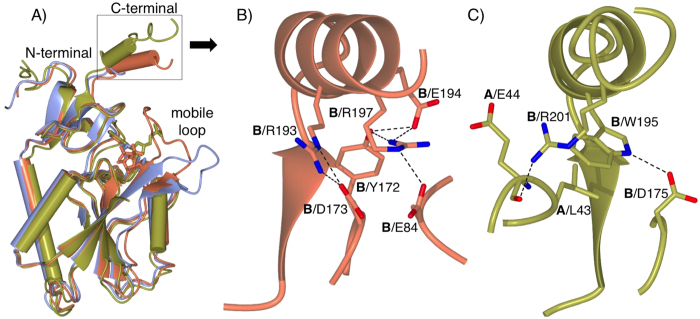
Comparison of the structures of TcrHGPRT and TbrHGPRT.(A) TheTcrHGPRT.PRibPP.HPP.Mg2+ complex (PDB code: 1TC2) is in brown, the TcrHGPRT.IMP complex (PDB code: 1P19) is in blue, and the TbrHGPRT.GMP is in lime green. Note that the C-terminal region, including the helix, in the TcrHGPRT.IMP is disordered. (B) Interactions at the C-terminal in the TcrHGPRT.PRibPP.HPP.Mg2+ complex (PDB code: 1TC2). (C) Interactions at the C-terminal in the TbrHGPRT.GMP complex.